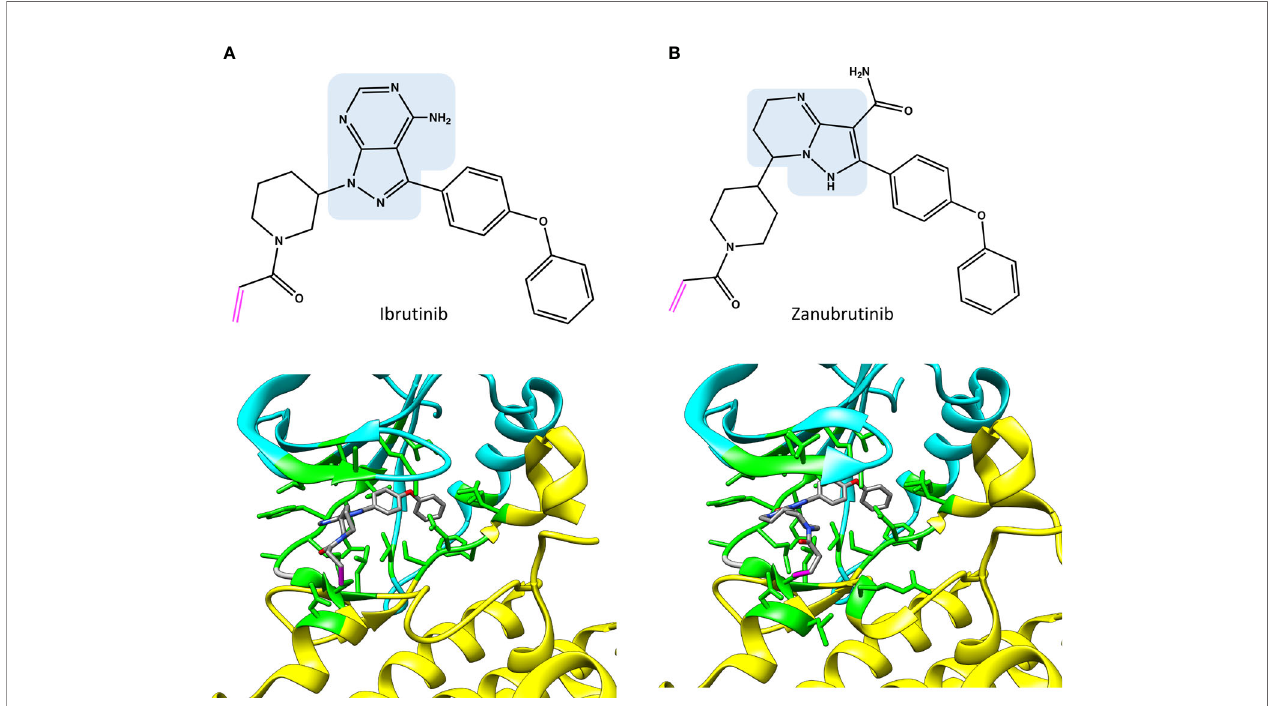
FIGURE 3 | Chemical structures and binding of covalent BTK inhibitors, (A) ibrutinib (5p9j), and (B) zanubrutinib (6j6m). Residues within 5 Å distance from inhibitor are shown in green. Atoms in the inhibitors are colored based on the elements, carbon gray, nitrogen blue, oxygen red. Covalent bond between C481 and inhibitor is in magenta. The structures have the same pose as in Figure 2C